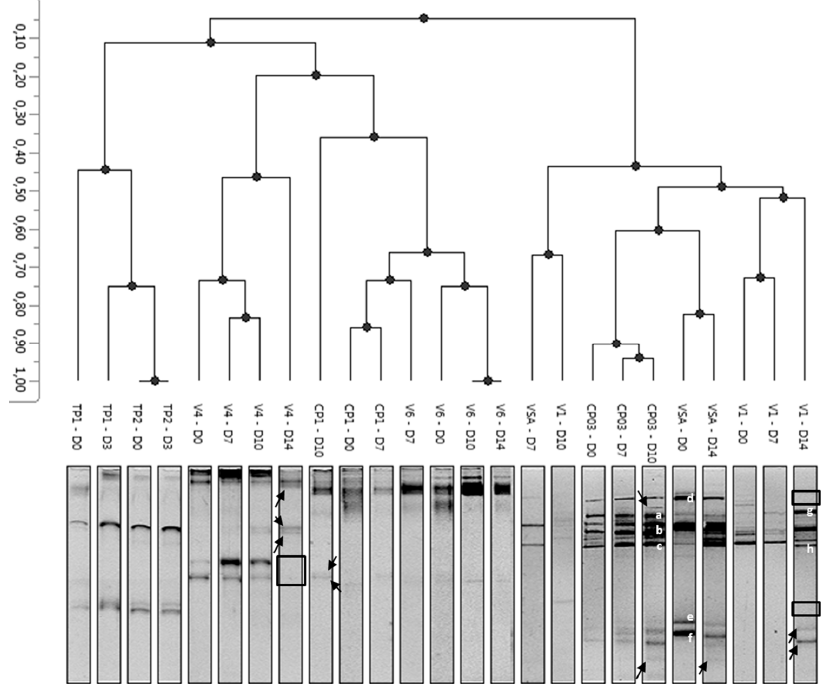
Figure 5. UPGMA dendrogram of PCR-DGGE profiles obtained for right batches of minimally- processed pineapple. D0, D3, D7, D10, and D14 correspond respectively to 0, 3, 7, 10, and 14 days of storage. Letters “a” to “h” label DNA bands which were sequenced. Arrows show bands appearing during storage and open boxes bands which disappear during storage.